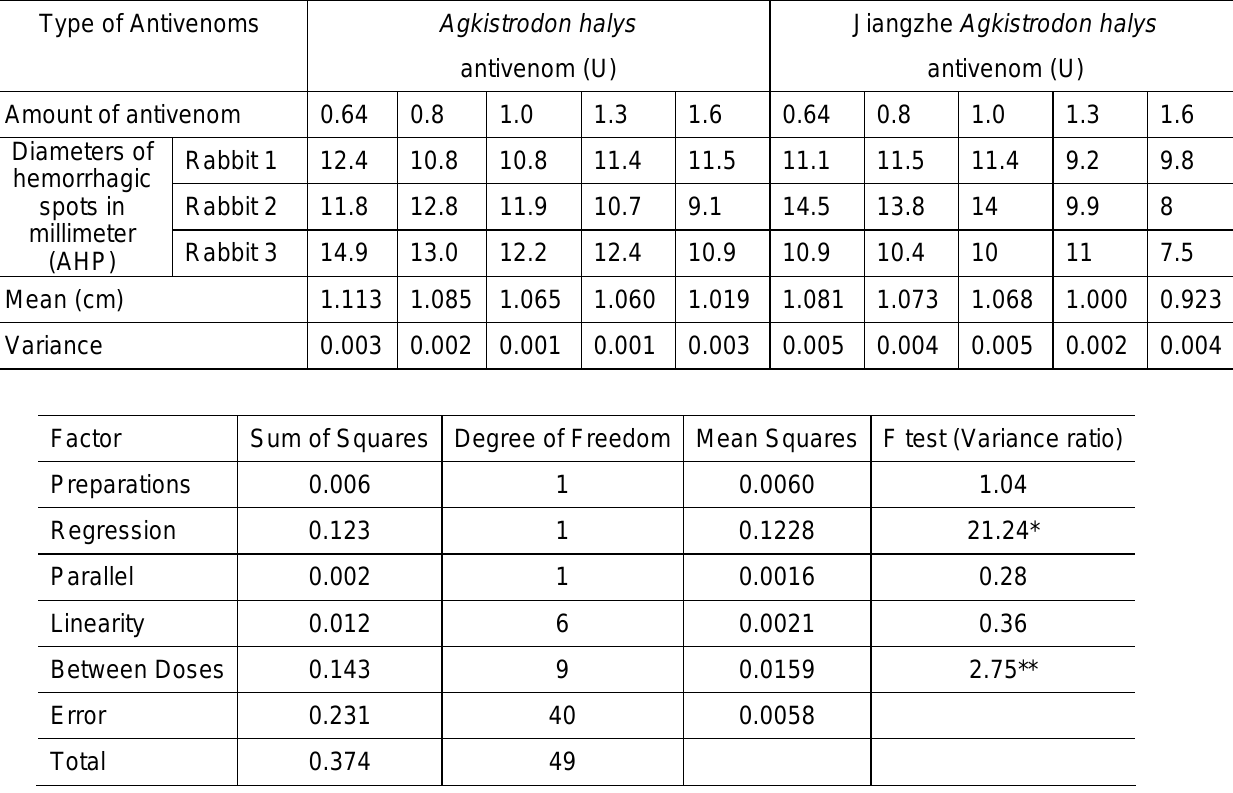
Table 7: Results of the antihemorrhagic potency (AHP) test of Agkistrodon halys and Jiangzhe Agkistrodon halys antivenoms against Jiangzhe Agkistrodon halys venom containing 18 µg (43 MHD) of the test